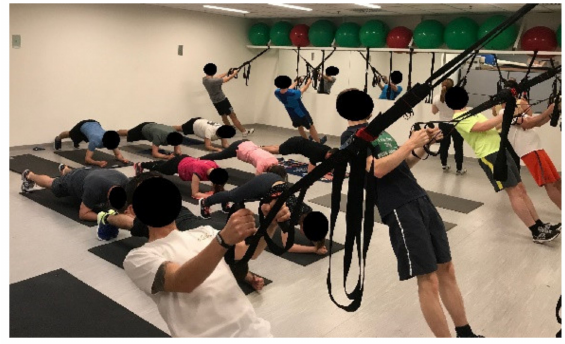
Figure 9. Functional